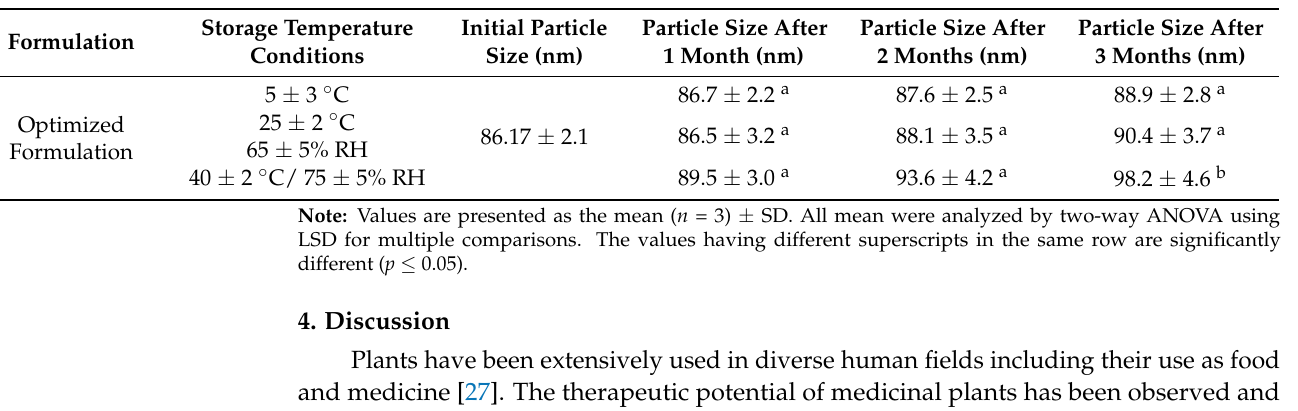
Table 3. Physical stability evaluation of the bergenin loaded